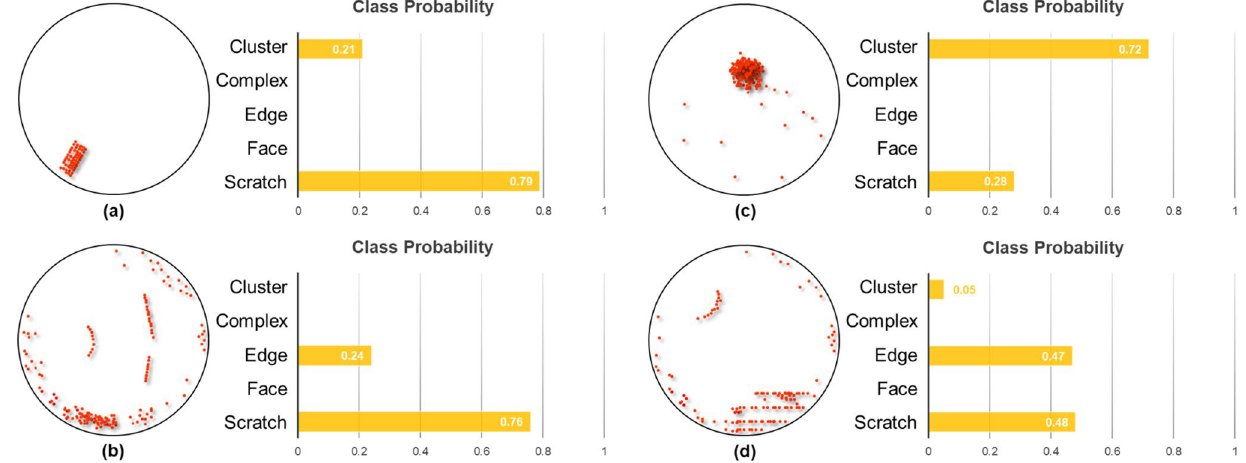
Figure 7. Examples of misclassified images: ( a ) actual class: Cluster, predicted class: Scratch, ( b ) actual class: Edge, predicted class: Scratch, ( c ) actual class: Scratch, predicted class: Cluster, ( d ) actual class: Edge, predicted class: Scratch